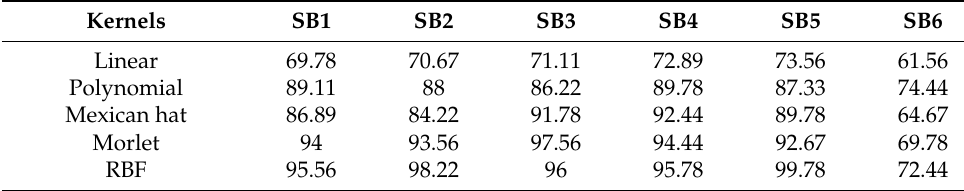
Table 4. Accuracy of SBs using multiple kernels of LS-SVM classifier.